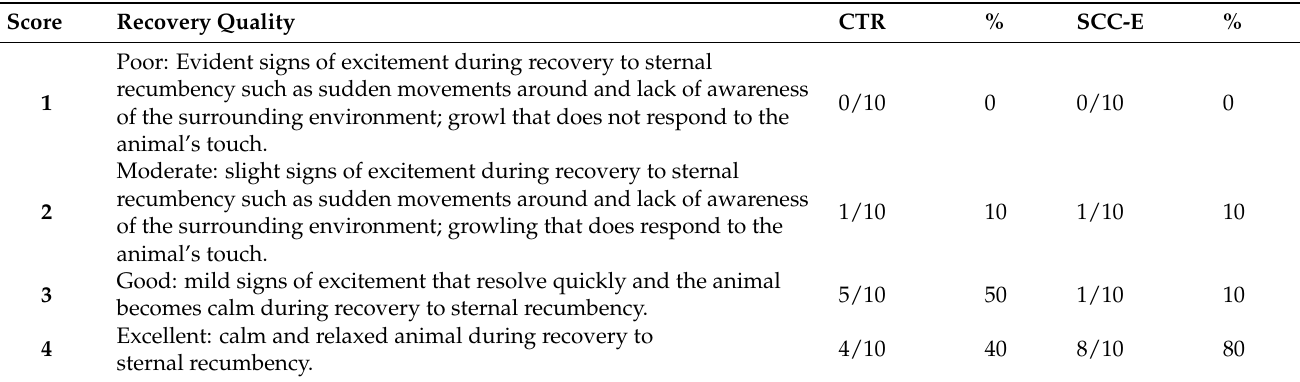
Table 4. Simple descriptive scale (SDS) scores were used to assess recovery quality score recovering from anaesthesia (between extubating until return to sternal decubitus) in cats undergoing ovariohysterectomy, with (group SCC-E) or without (group CTR) sacrococcygeal epidural ( n = 10 in each